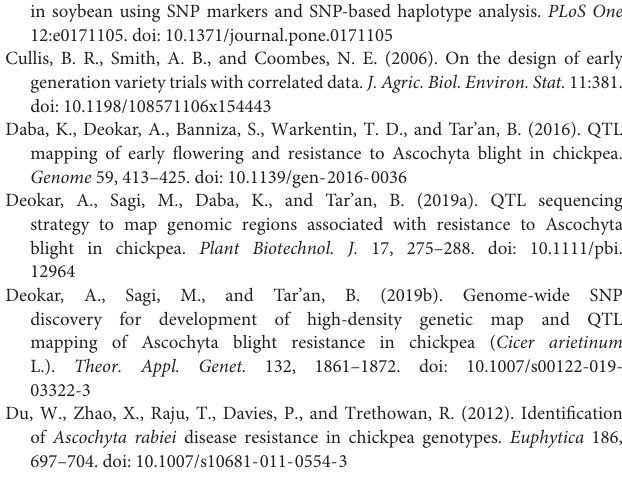
Supplementary Figure 1 | A neighbor-joining phylogenetic tree of GWAS set of Australian chickpea genotypes. Supplementary Figure 2 | LD decay plots of all eight chickpea chromosomes and Ca1–Ca8. The squared correlation coefficient r2 values (Y-axis) were plotted against the physical distance in mega base pairs (Mbp) (X-axis). Supplementary Figure 3 | Principal component analyses of GWAS set and F 3 populations. (A) GWAS set and PBA Drummond/CICA1841 (based on 316 common DArTseq markers). (B) GWAS set and PBA Captain/CICA1841 (based on 272 common DArTseq markers); blue: kabuli genotypes, green: